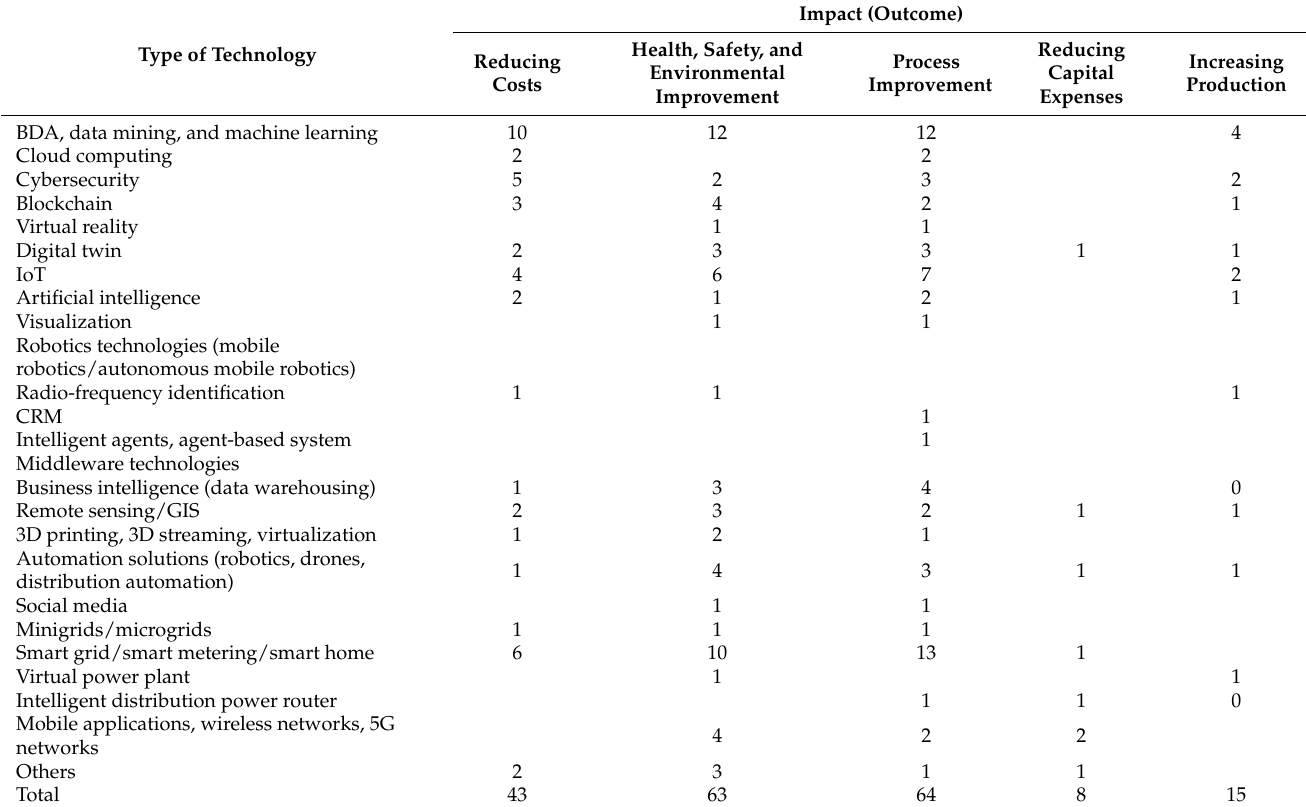
Table 6. The impact of each type of technology in the energy field 1